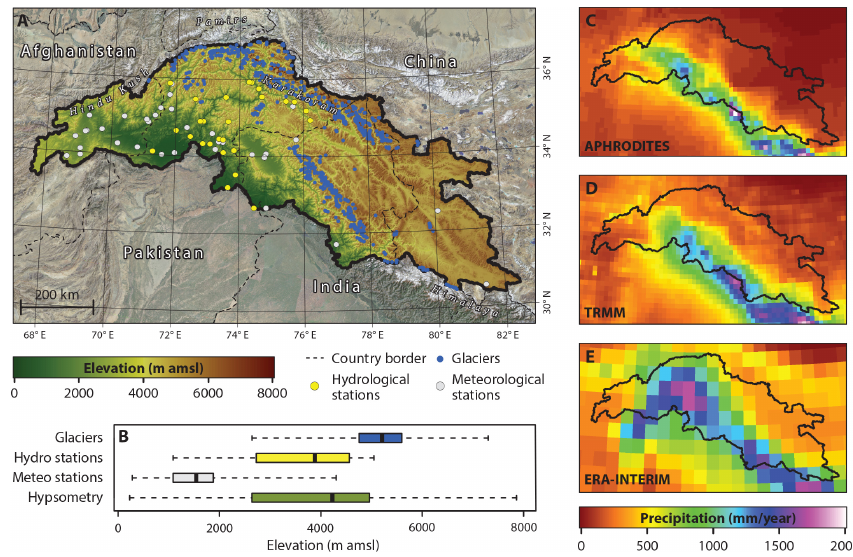
Figure 1. Overview of the UIB (Lehner et al., 2008), basin hypsometry and three gridded precipitation products. (a) shows the digital elevation model, the location of the major glacier systems (area >5km 2 ), the available stations in the Global Summary of the Day (GSOD) of the World Meteorological Organization (WMO) and the hydrological stations used for validation. Panel B shows box plots of the elevation distribution of the basin, the large glacier systems, the GSOD meteorological stations and the average elevation of the catchment area of each hydrological station. (c) to (e) show the average gridded annual precipitation between 1998 and 2007 for the APHRODITE (Yatagai et al., 2012), TRMM (Huffman et al., 2007) and ERA-Interim (Dee et al., 2011) data